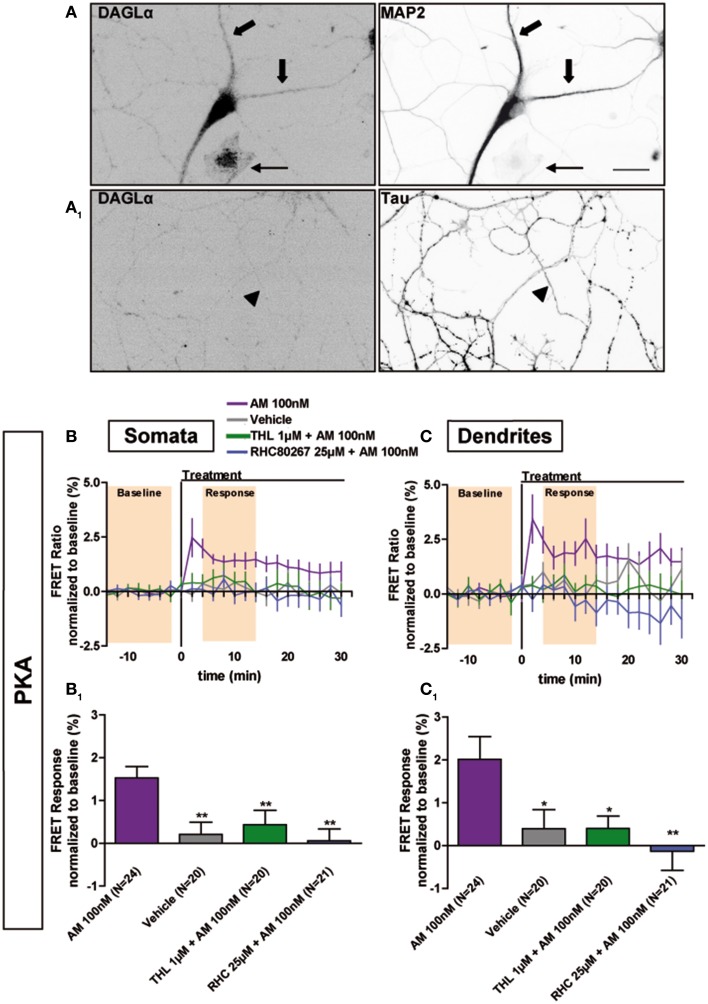
Constitutive activation of somatodendritic CB1Rs requires locally synthesized endocannabinoids. (A) Simultaneous immunolabeling of fully-polarized (DIV9) neurons with anti-DAGLα antibody and either anti-MAP2 (A) or anti-Tau (A1) antibodies. Large arrows indicate dendrites, arrow-heads indicate axon and the thin arrow shows an astrocyte. (B,C) Averaged somatic and dendritic responses of AKAR4-Kras expressing neurons to inverse-agonist AM281 (AM), with or without inhibiting DAGL activity. The FRET ratio normalized to baseline was calculated for each neuron with a time-resolution of 2 min. The curves represent mean ± S.E.M. of the FRET ratio for all imaged neurons at each time point. Addition of 100 nM AM but not of vehicle at t0 results in elevated PKA activity, revealing constitutive CB1R activation, which is significantly decreased after DAGL inhibition either by tetrahydrolipstatin (THL) 1 μM or RHC80267 25 μM. Data information: Data are expressed as mean ± S.E.M.; Statistical analysis was realized with one-way ANOVA followed by Newmann-Keuls post-test; *p < 0.05, **p < 0.01. Scale bar: 20 μm (A,A1).